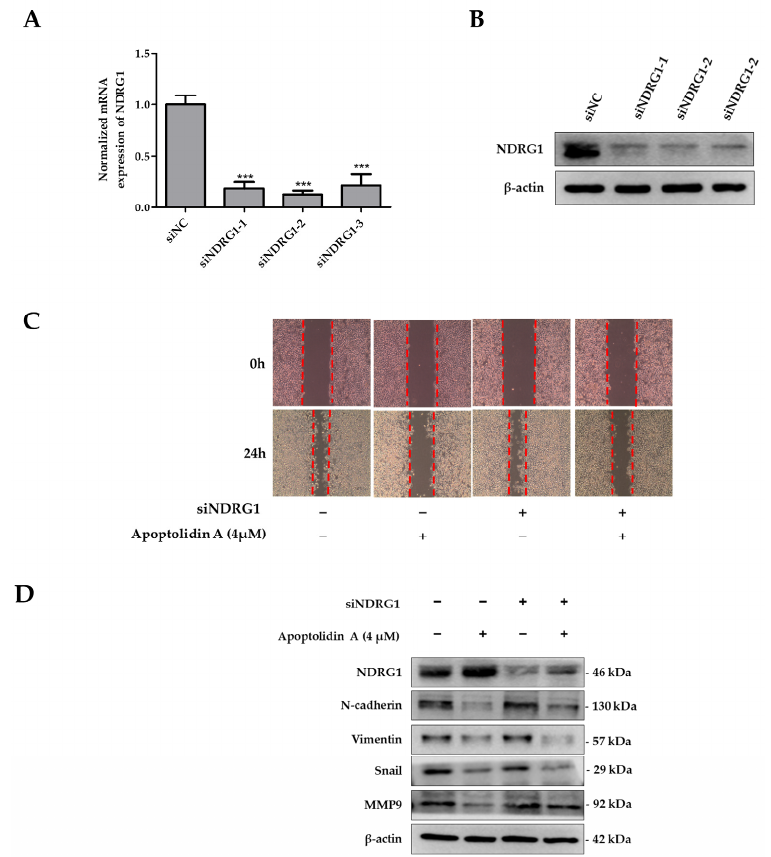
Figure 6. Effects of silencing NDRG1 on cell migration of apoptolidin A in RKO cells. The RKO cells were transfected with a set of NDRG1 siRNA for 48 h, and then PCR and immunoblot analysis were used to determine NDRG1 gene ( A ) and protein expression ( B ) in RKO cells. *** p < 0.001 indicate statistically significant difference compared with the siNC-treated control. ( C ) RKO cells were transfected with a selected siNDRG1 for 48 h and then seeded in six wells. A wound healing assay was used to assess the migration of RKO cells transfected with a particular siNDRG1 after 24 h apoptolidin A treatment. ( D ) RKO cells were transfected with siNDRG1 for 48 h and then treated with apoptolidin A for 24 h. The expression of EMT-related proteins was detected by immunoblotting. β -Actin was used as an internal